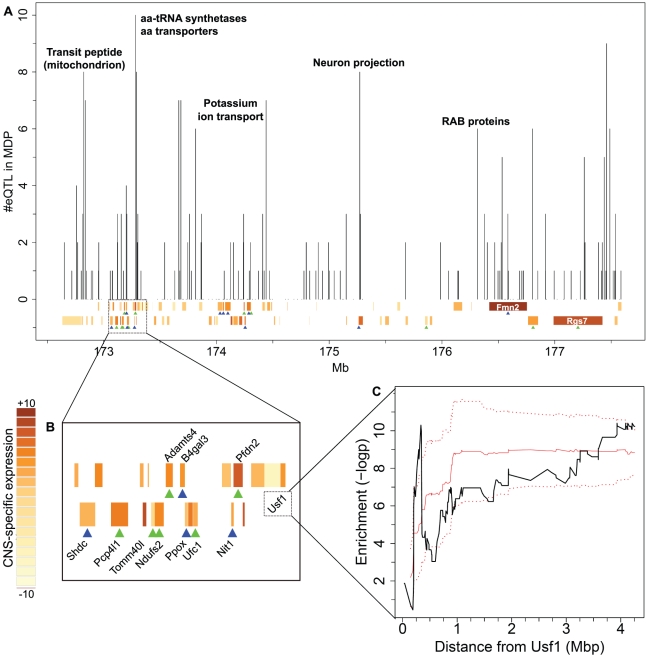
Using MDP eQTL to dissect an eQTL hotspot on distal Chromosome 1.
A: Overview of candidate regulators number of eQTL mapping to Qrr1. Vertical bars show the number of target genes per marker in MDP (for every gene, the strongest eQTL in MDP within Qrr1 is selected). Labels at the bars illustrate enriched functional categories. Genes encoded in Qrr1 are shown at the bottom (top: forward strand, bottom: reverse strand). The color gradient reflects CNS expression specificity (t-statistic). Green triangles indicate cis-eQTL in the BXD dataset, whereas blue triangles represent a cis-eQTL detected in both BXD and MDP datasets. B: Detail of Qrr1p around 173 Mb. Labels of selected genes are shown. C: Enrichment of Usf1 targets along Qrr1. Black line: enrichment (-logp) as a function of physical distance from the transcription factor, i.e. the length of an exploratory interval centered on Usf1. Red lines show results for randomized Usf1 targets (Solid red line: average across 100 randomizations; dotted red lines: average ± standard deviation).